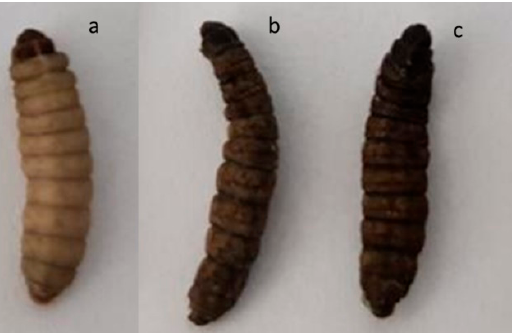
Figure 5. Galleria mellonella larvae. ( a ) Healthy larva without treatment (naïve); ( b ) dead larvae after AgNO 3 in exposure to dark; ( c ) dead larvae after AgNO 3 in exposure to red light (15 J cm − 2 ).